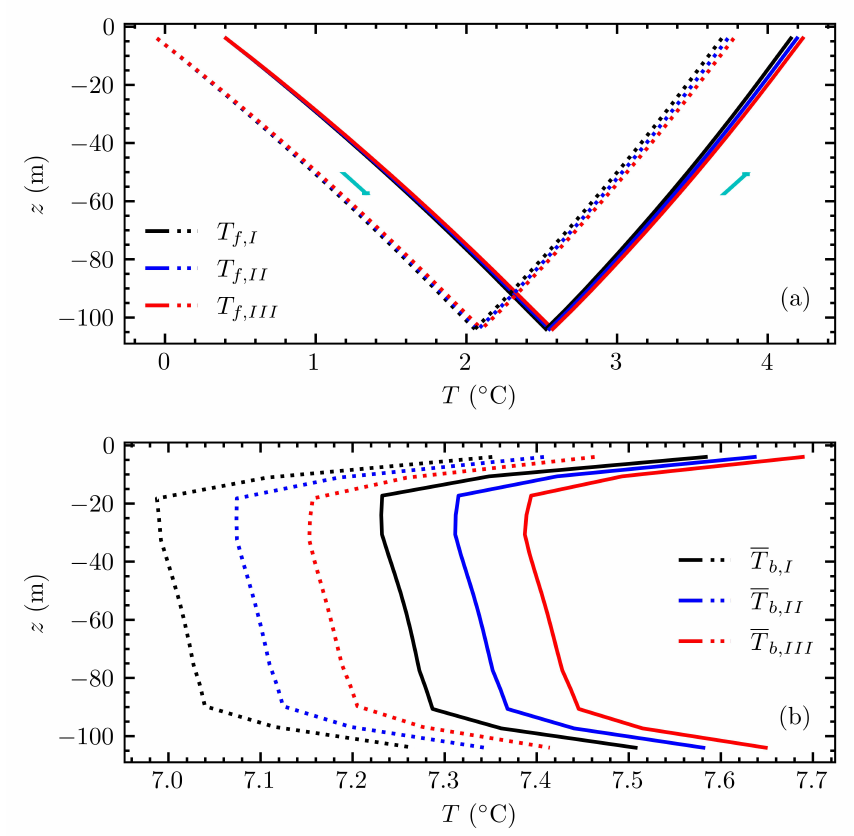
Figure 13. Fluid and borehole wall temperature profiles for each equivalent borehole at 7029 min: ( a ) fluid temperature profiles for the FEA (dotted line) and the proposed method (solid line) for each equivalent borehole, and ( b ) equivalent borehole wall temperature profiles for the FEA method (dotted line) and the proposed method (continuous